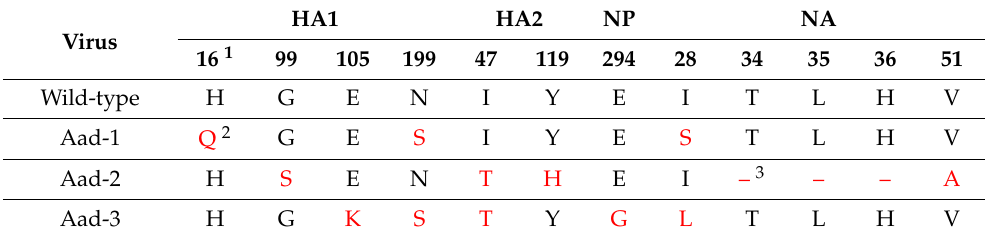
Table 1. Amino acid substitutions found in A549-adapted viruses. Virus